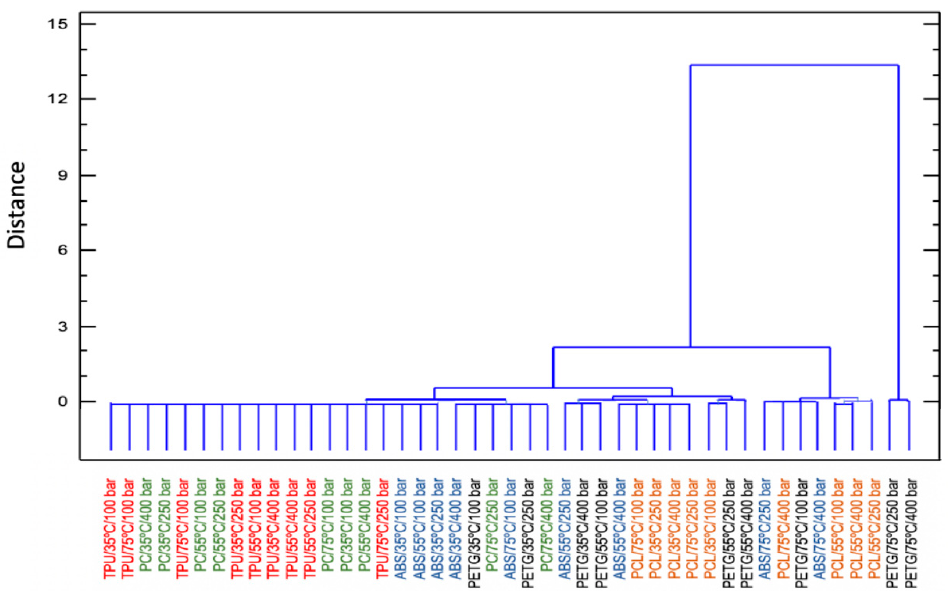
Figure 3. Cluster analysis for the swelling effect of the five polymers under study.